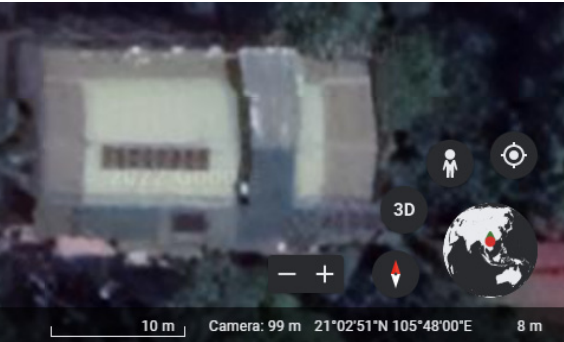
Figure 11. The actual solar power station at the Institute of Energy Science (Google Earth).